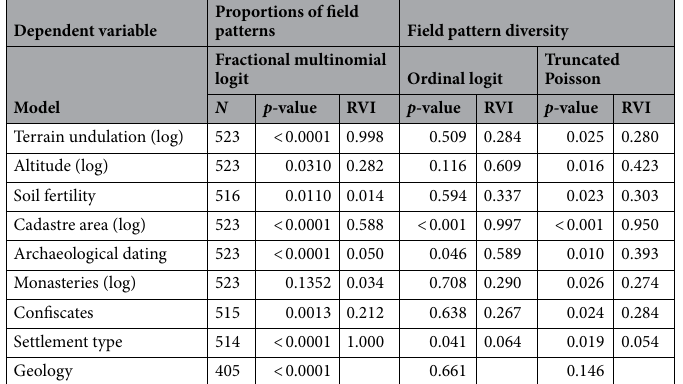
Table 2. Summary statistics for bivariate and multivariate regressions. N the number of observations in bivariate regressions; p -value overall model p -value in bivariate regressions; RVI relative variable importance, i.e., sum of the Akaike weights across all models containing the given covariate in the all-subset regressions ( geology was not included in the all-subset